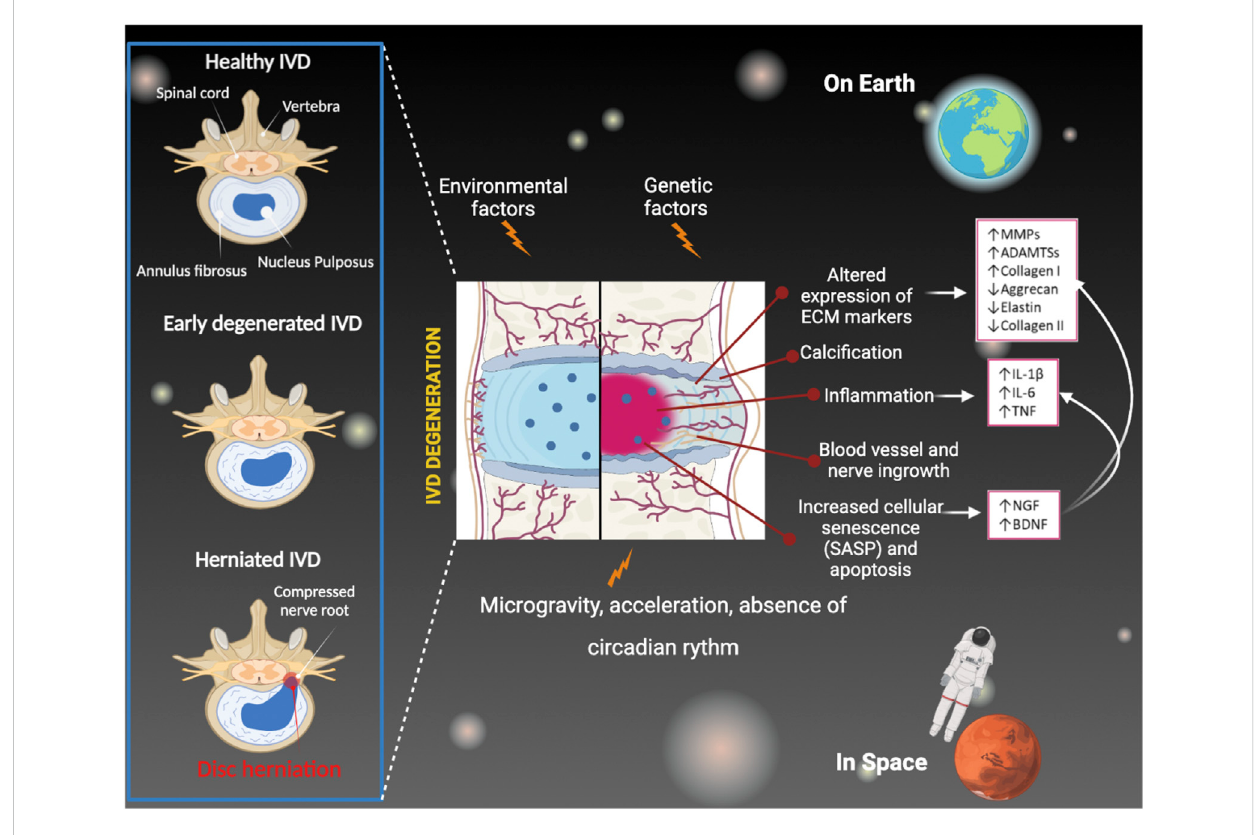
FIGURE 1 IVD degeneration mechanisms under Earth ’ s conditions and during space fl ight and